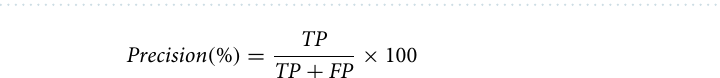
Figure 10. ADNI dataset sample